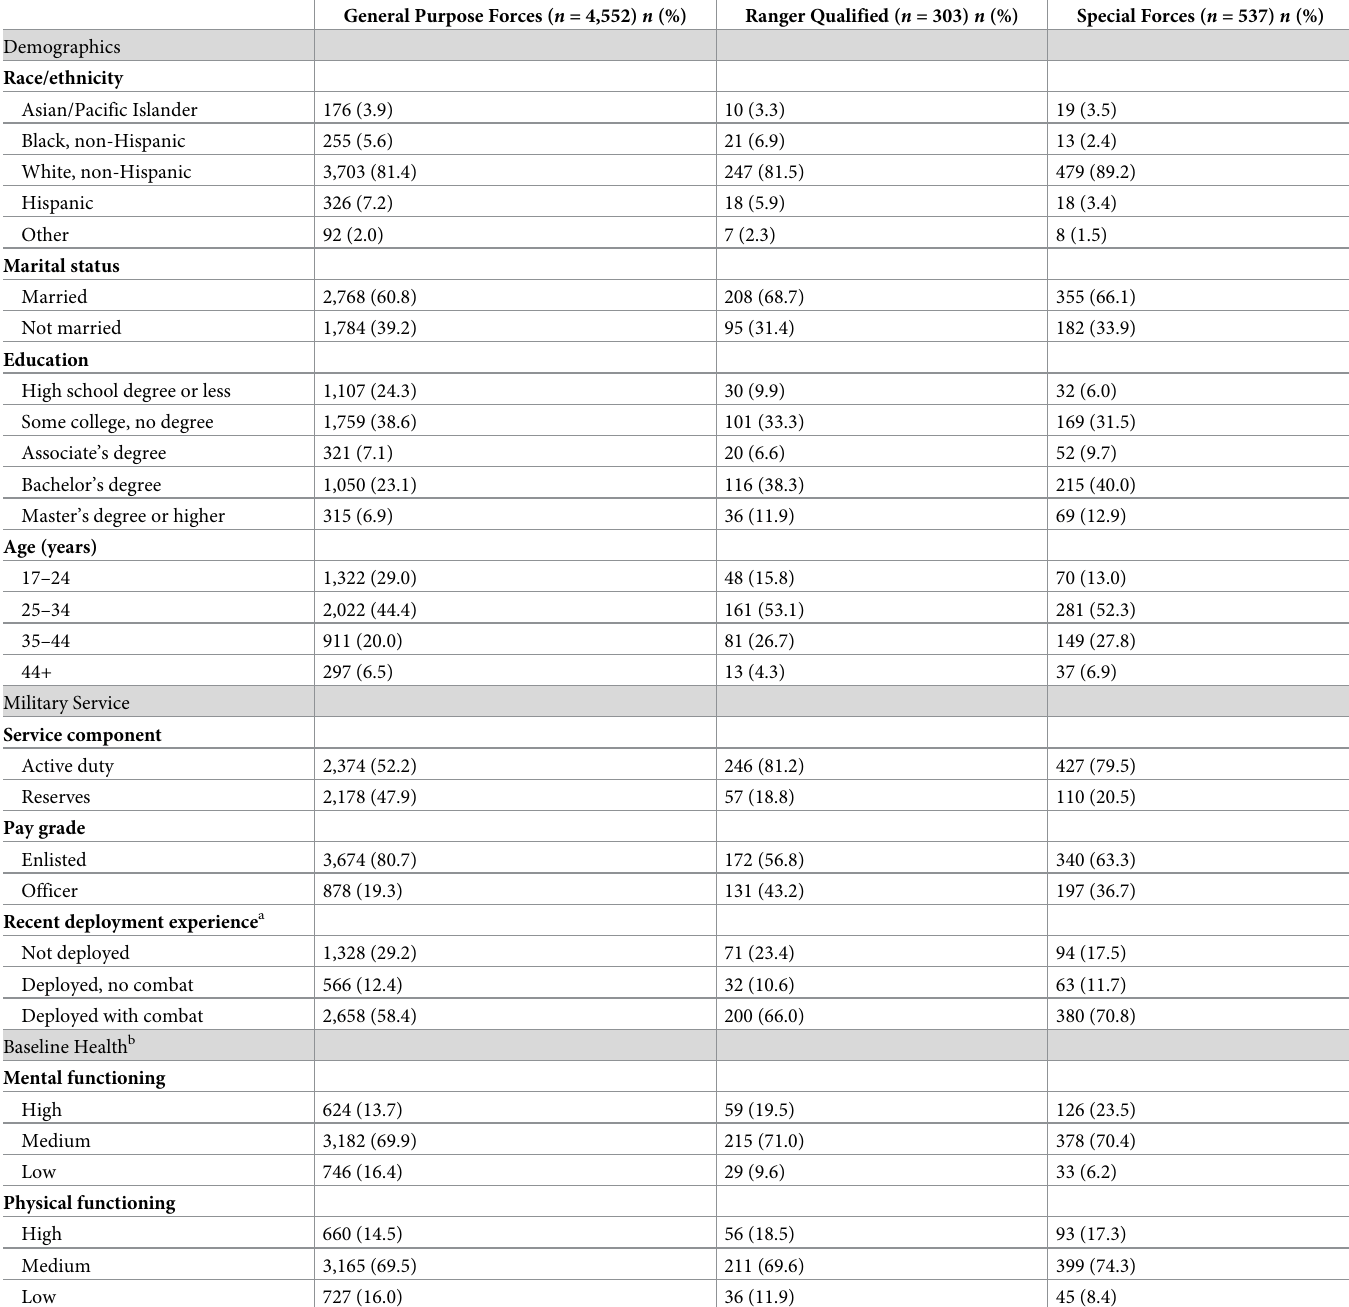
Table 1. Baseline characteristics of soldiers by Army specialization, the Millennium Cohort Study �